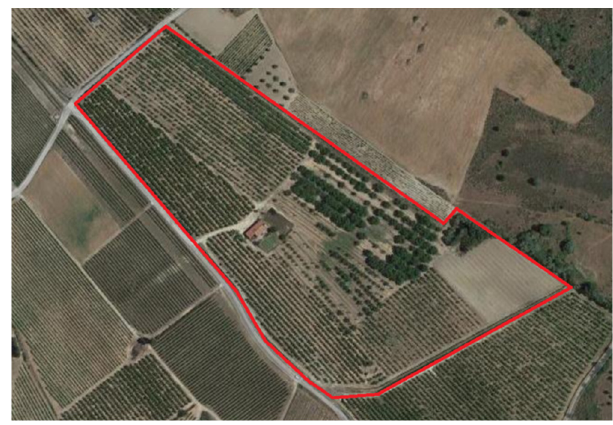
Figure 7. Search study field.